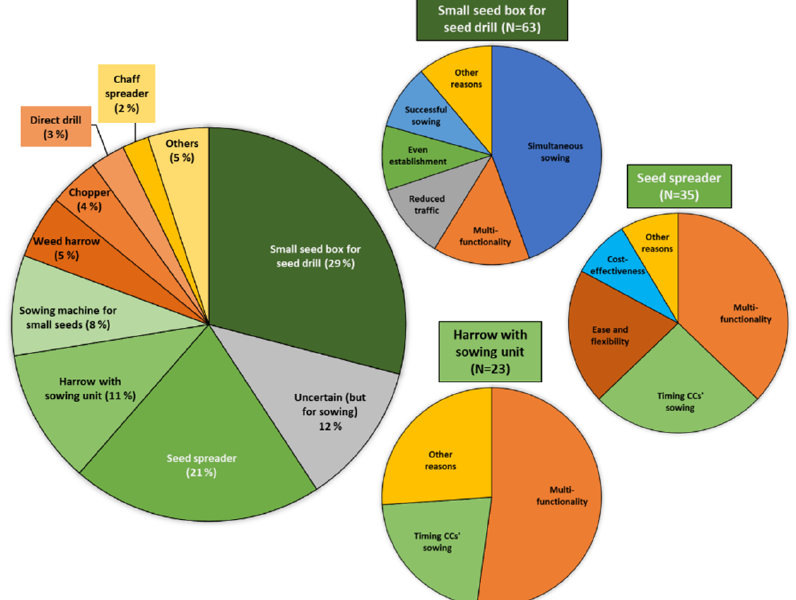
Figure 13. On the left, the share of machines and equipment (%) that farmers had invested in according to their free-word answers: 435 responses (corresponding to 39% of all respondents) with information on 461 investments. On the right, reasons given by farmers for the three most common investment.